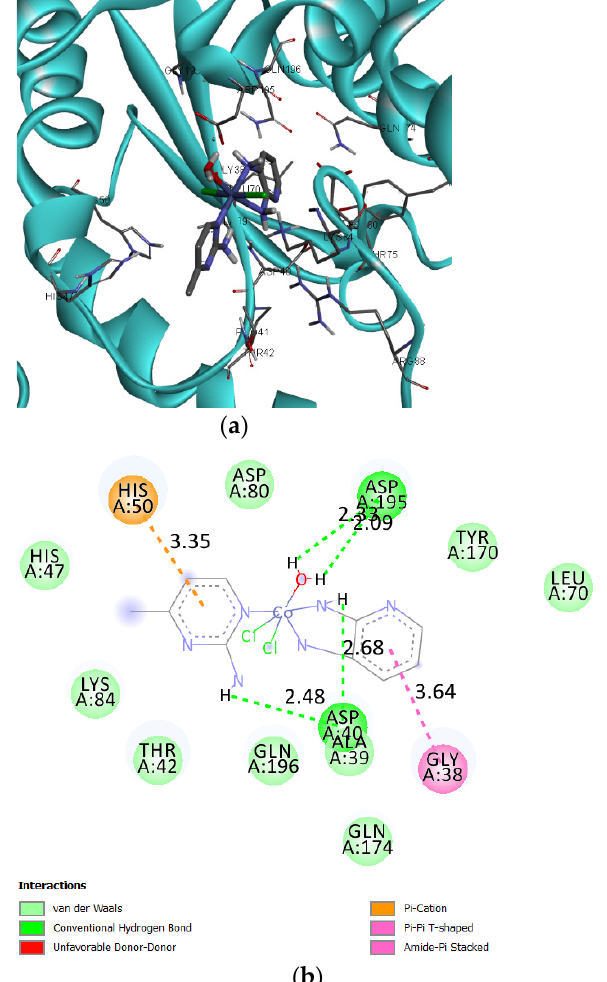
Figure 10. ( a ) Three-dimensional (3D) and ( b ) two-dimensional (2D) interaction of Co(II) complex with the active site of tyrosyl tRNA synthetized (PDB: 1JIJ).